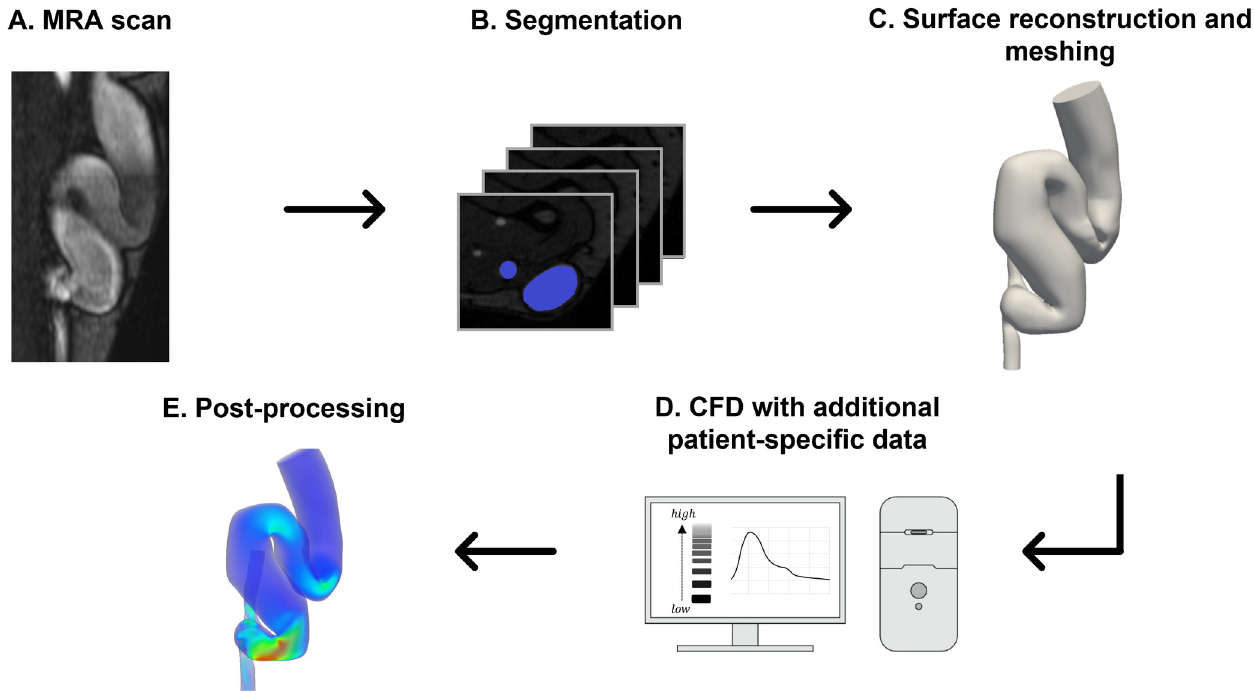
Fig 1. Overview of the SIPAct level estimation in patient-specific AVF geometries. MRA–magnetic resonance angiography; CFD–computational fluid dynamics.